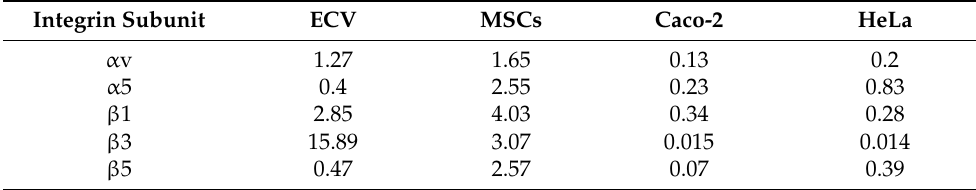
Table 2. Integrin subunit mRNA expression (fold